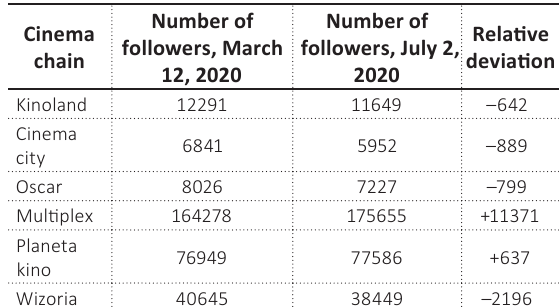
Table 2. Dynamics of the number of subscribers to the pages of cinema networks on